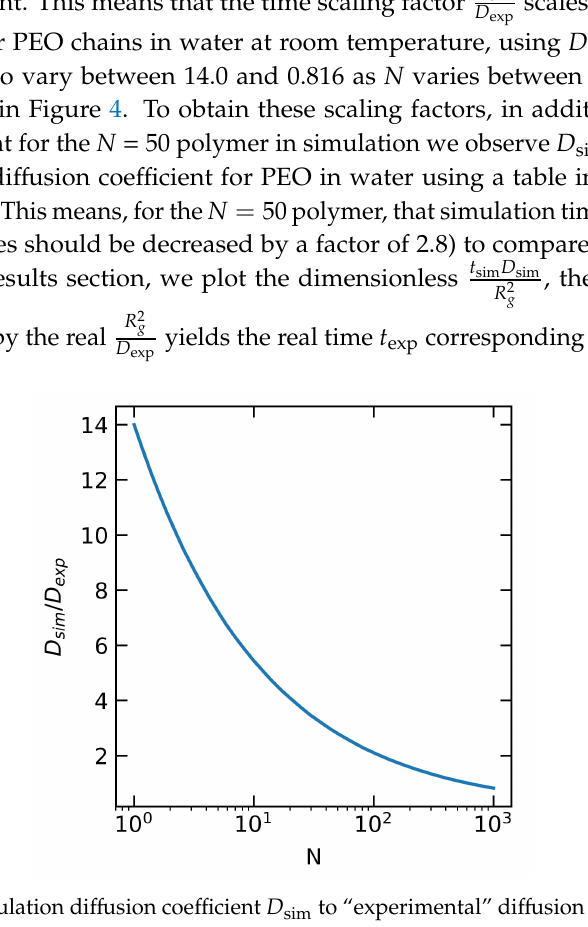
Figure 4. Ratio of simulation di ff usion coe ffi cient D sim to “experimental” di ff usion coe ffi cient D exp as a function of N , the number of monomers. This serves as the conversion factor to convert simulation time to “experimental time,” as discussed in the